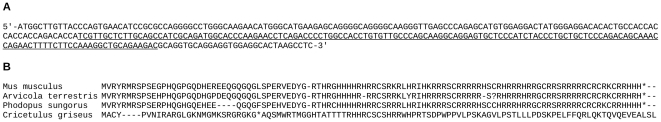
Protamine 2 of Cricetulus griseus.
A - Coding sequence of the protamine 2 gene of C. griseus. Underlined is a region with null homology to any protamine sequence. B - Comparison between protamine 2 protein sequences of Mus musculus, A. terrestris, P. sungorus and C. griseus.